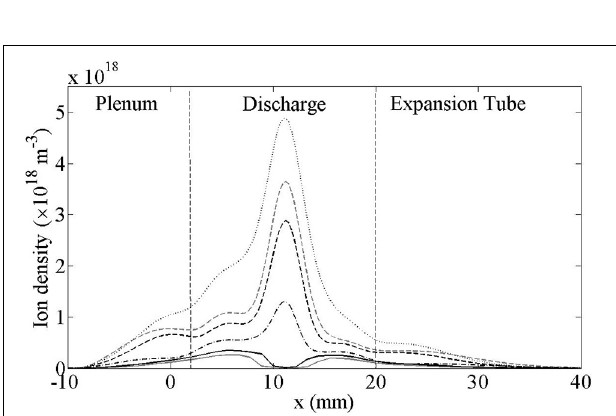
FIGURE 8 | Ion saturation currents along the central axis measured using a Langmuir Probe (top) and simulated ion density along the central axis (bottom).